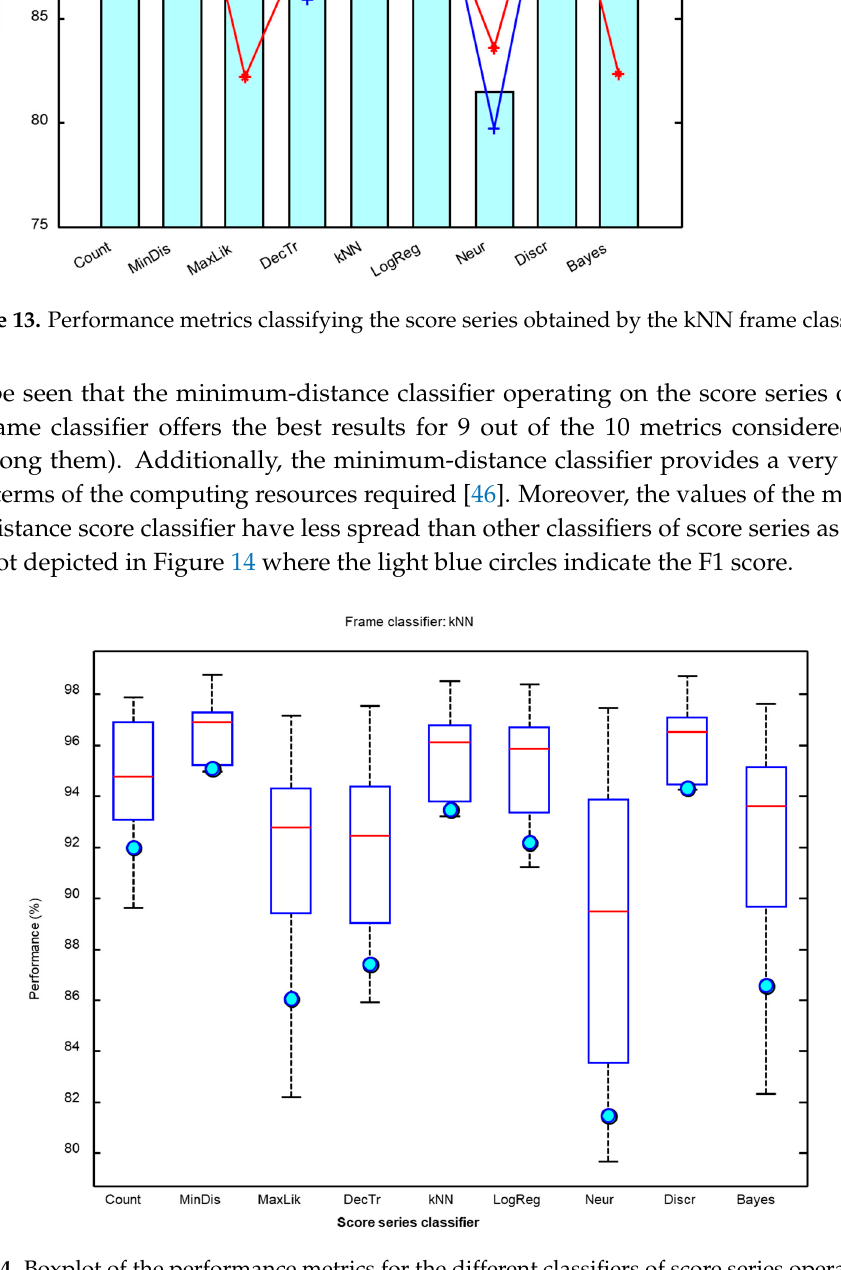
the results obtained by the kNN frame